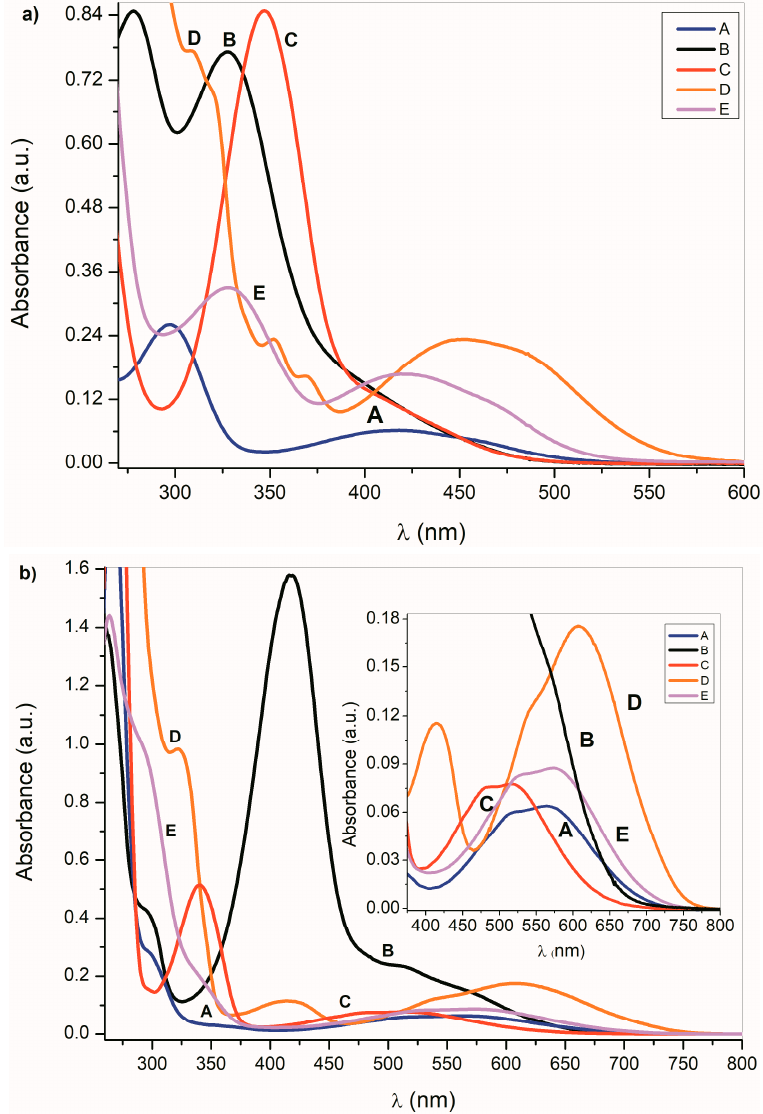
Figure 1. ( a ) Ultraviolet–visible (UV–Vis) spectra A – E (1 × 10 − 4 mol·dm − 3 ) and ( b ) corresponding azanions in the presence of tetrabutylammonium fluoride (TBAF) in dimethyl sulfoxide (DMSO) (1 × 10 − 2 mol·dm − 3